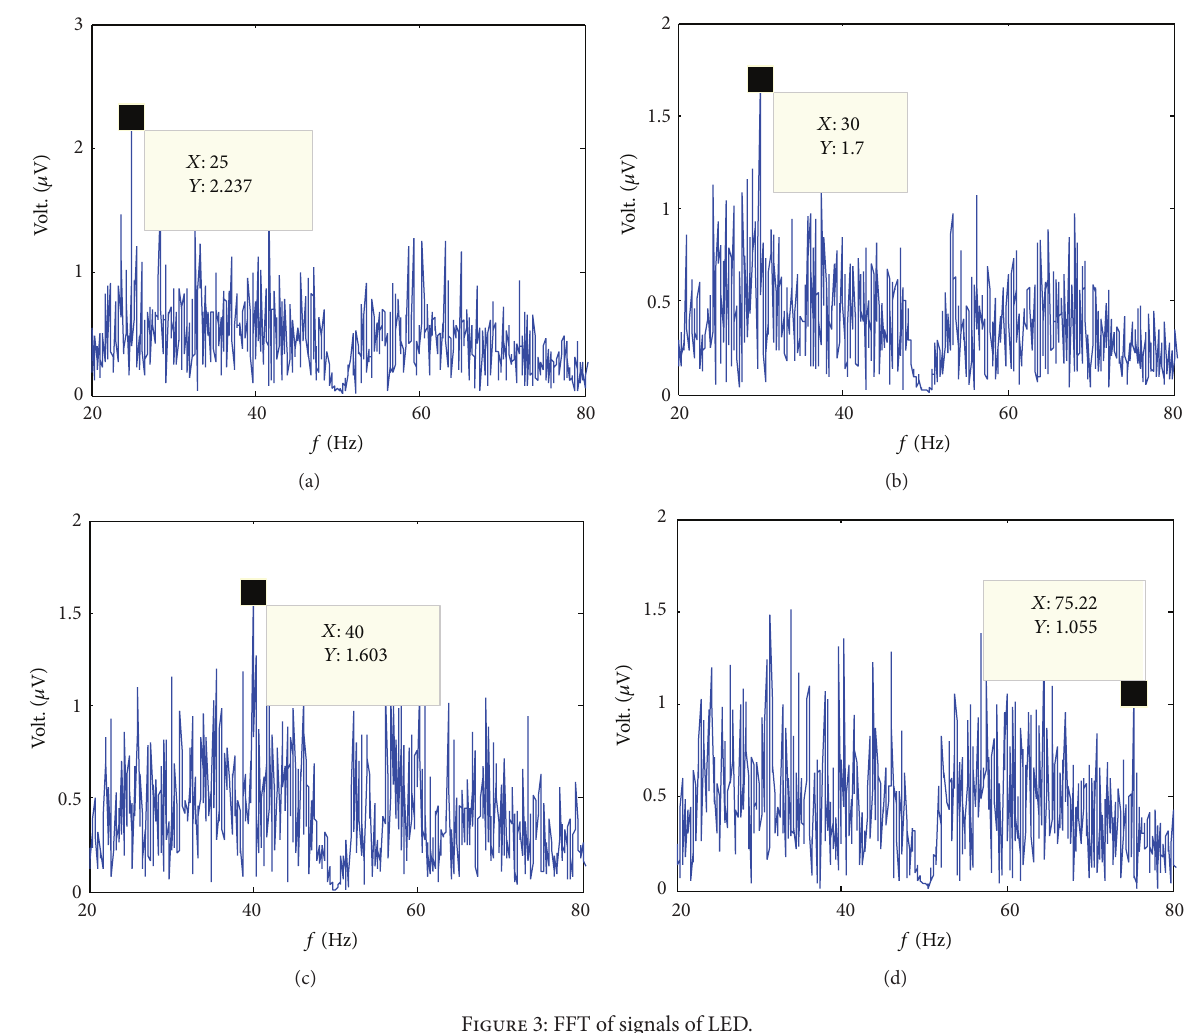
Figure 3: FFT of signals of LED.